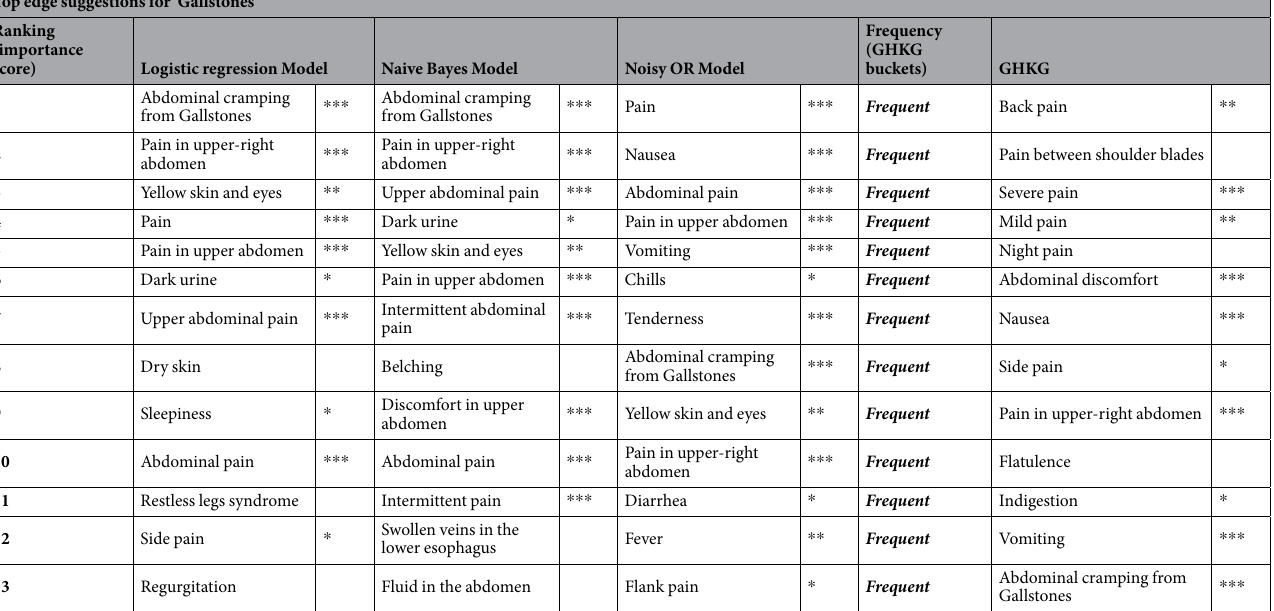
Table 2. Top edge suggestions by models for ‘Gallstones’. The number of shown edges corresponds to the number of edges in the GHKG. For logistic regression, naive Bayes and noisy OR the edges are ranked by their relative importance score. For the GHKG, the edges are sorted according to two broad buckets symptom frequency that are provided in the graph [‘frequent’ and ‘always’]. The internal ordering of the edges within a given bucket is random. The stars associated with each edge represent the expected frequency for which “disease A causes symptom B” as rated by physicians. [‘ *** ’ = ‘always happens’, ‘ ** ’ = ‘sometimes happens’, ‘ * ’ = ‘rarely happens’, ‘’ = ‘never happens’].